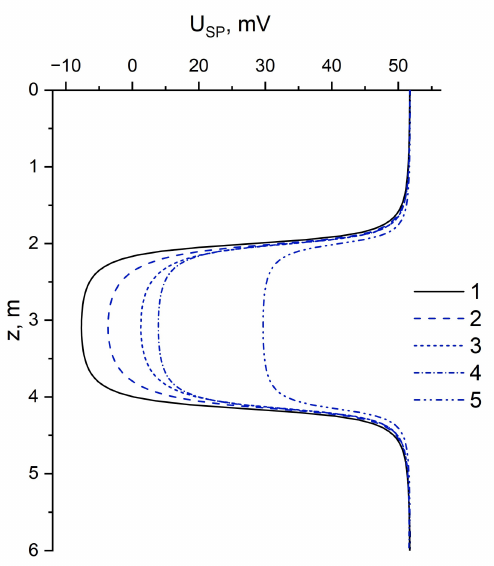
Figure 7. SP log diagrams in a model of alternating sandstone beds of different thicknesses in shale sediments as a function of reservoir/mud resistivity ratio.